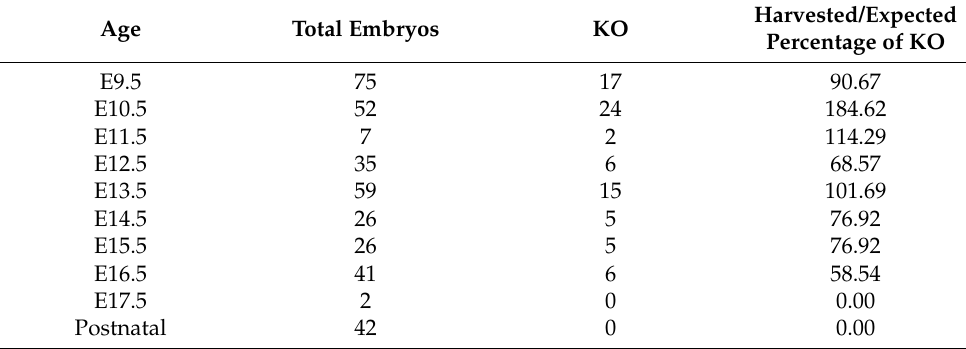
between pulmonary artery and aorta at E13.5 (blue arrows), and the knockout hearts also display a less deep left-right ventricular groove (red arrows). ( F – I ) At E15.5, the N1KO hearts displayed OFT alignment defects but no obvious ventricular compaction defects. The blue arrows indicate aorta (Ao), pulmonary artery (PA) and their valves, red arrows indicate ventricular groove. Scale bars: 100 µ m. Table 1. The survival rate of Nkx2.5 cre/+ ; Notch1 fl/fl (KO).